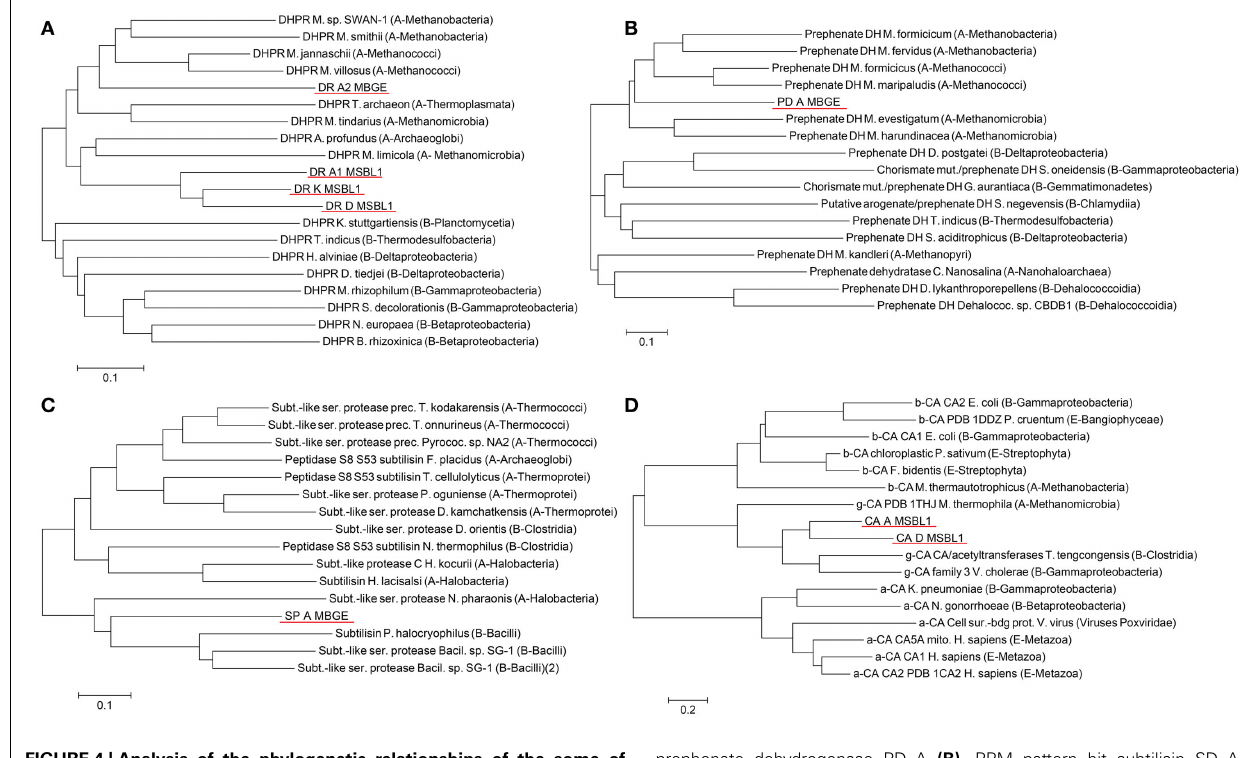
prephenate dehydrogenase PD_A (B) , PPM pattern hit subtilisin SD_A (C) and manual PPM hits γ carbonic anhydrase CA_A